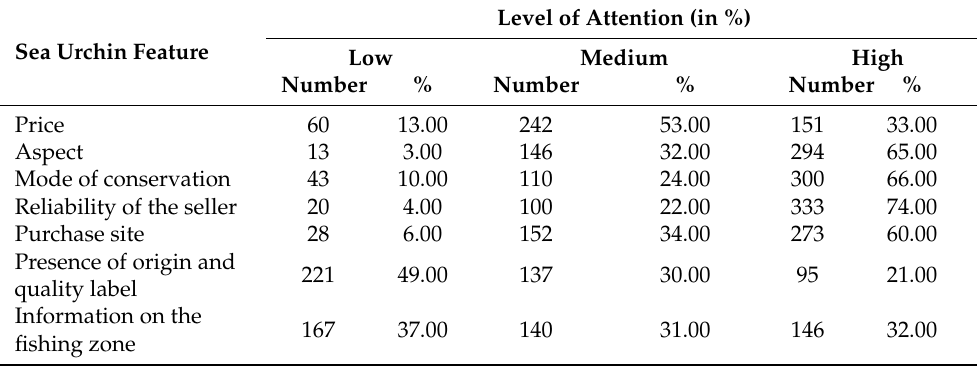
Table 5. Self-level attention on the characteristics of sea urchin among Apulian consumers (in % of